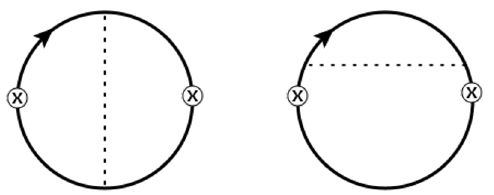
Figure 1 . Feynman diagrams for the calculation of the heavy-quark correlators in the large- β 0 limit. The rightmost diagram must be counted twice. Dashed lines represent gluon propagators with light-quark bubble insertions. Crosses stand for the insertion of the currents of eq.